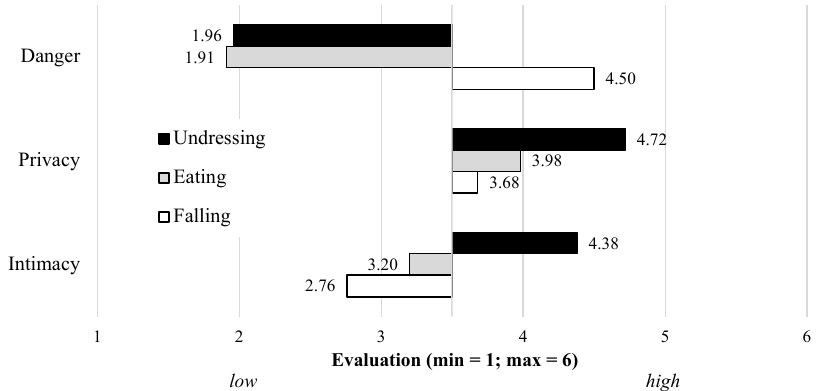
Figure 5. Perceptions of using video-based AAL technology in different situations (n =